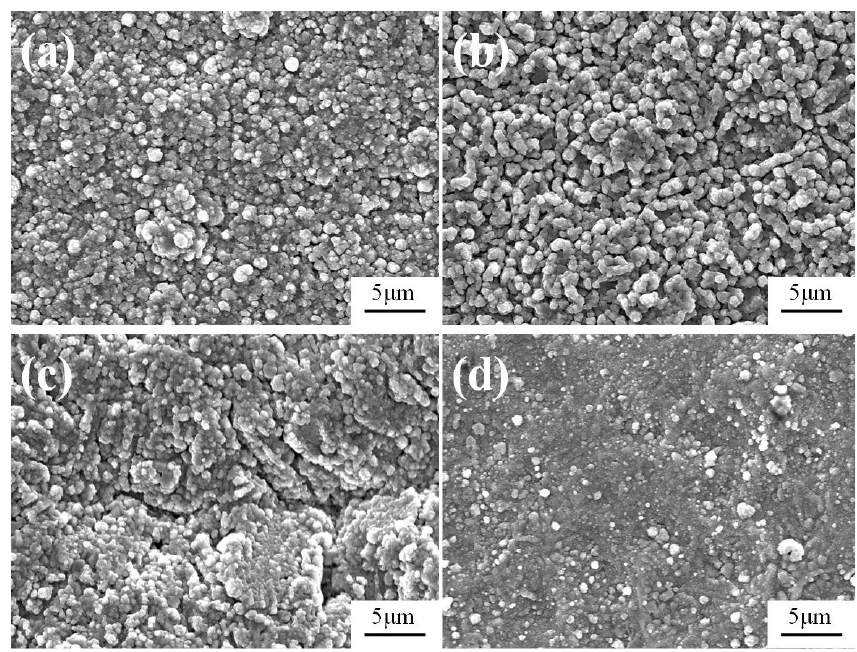
Figure 2. Surface morphologies of the Fe-Al-Cr alloyed layers obtained at different sample temperatures: ( a ) 750 °C; ( b ) 800 °C; ( c ) 850 °C; ( d ) 900 °C.